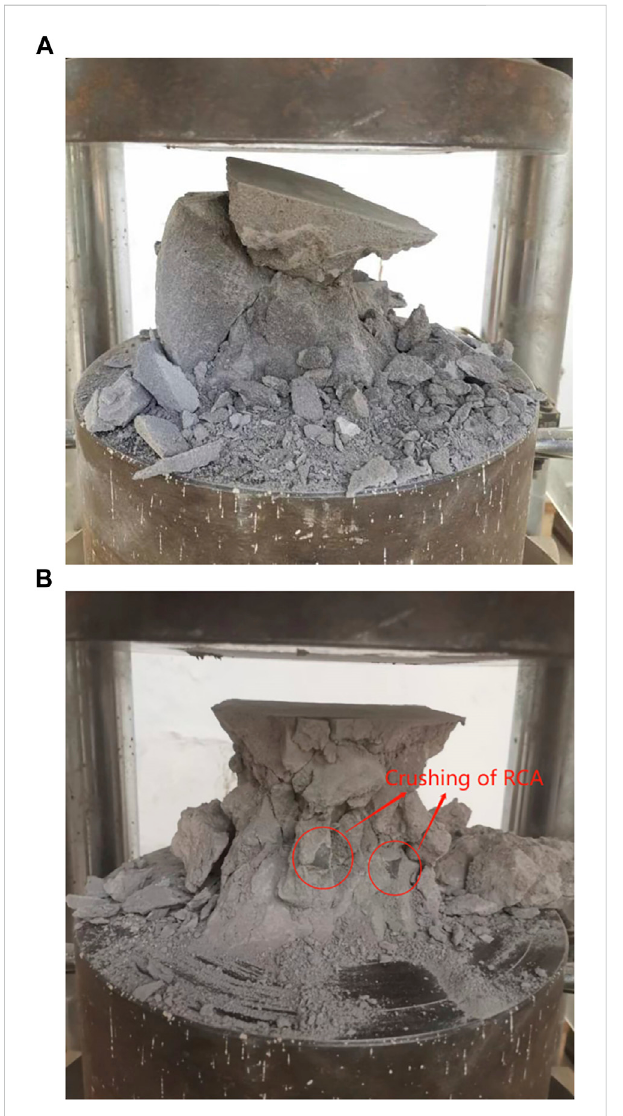
FIGURE 4 Failure morphology of test blocks: (A) Ordinary foam concrete (without aggregate); (B) RCAFC.